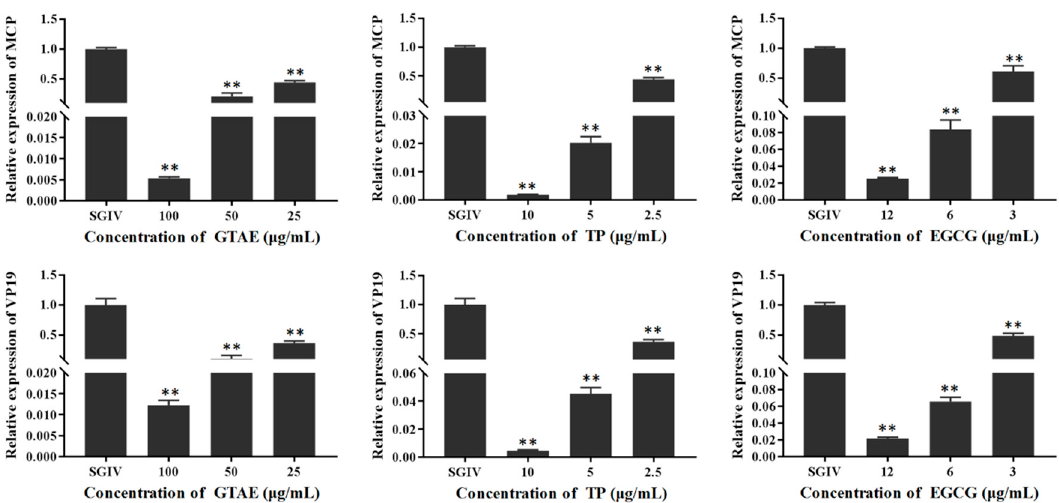
Figure 5. Antiviral activities of green tea components against SGIV tested with qPCR at 48 h. GS cells incubated with SGIV and diluted green tea components (GTAE at 100, 50, or 25 µ g/mL; TP at 10, 5, or 2.5 µ g/mL; and EGCG at 12, 6, or 3 µ g/mL) constituted the test groups. Untreated SGIV-infected GS cells constituted the positive control group. The antiviral effects were analyzed as the inhibition of MCP and VP19 expression. ** indicates p < 0.01.